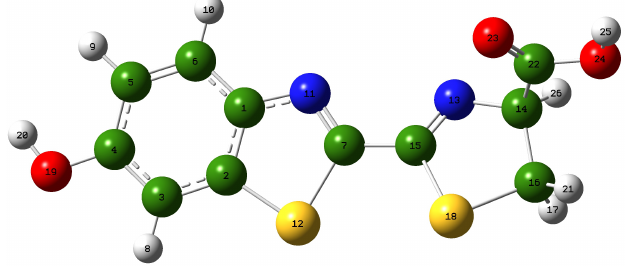
Figure 1. Gas phase optimized geometry of native D-luciferin molecule. Green, white, yellow, blue, and red colors represent C, H, S, N, and O atoms respectively.